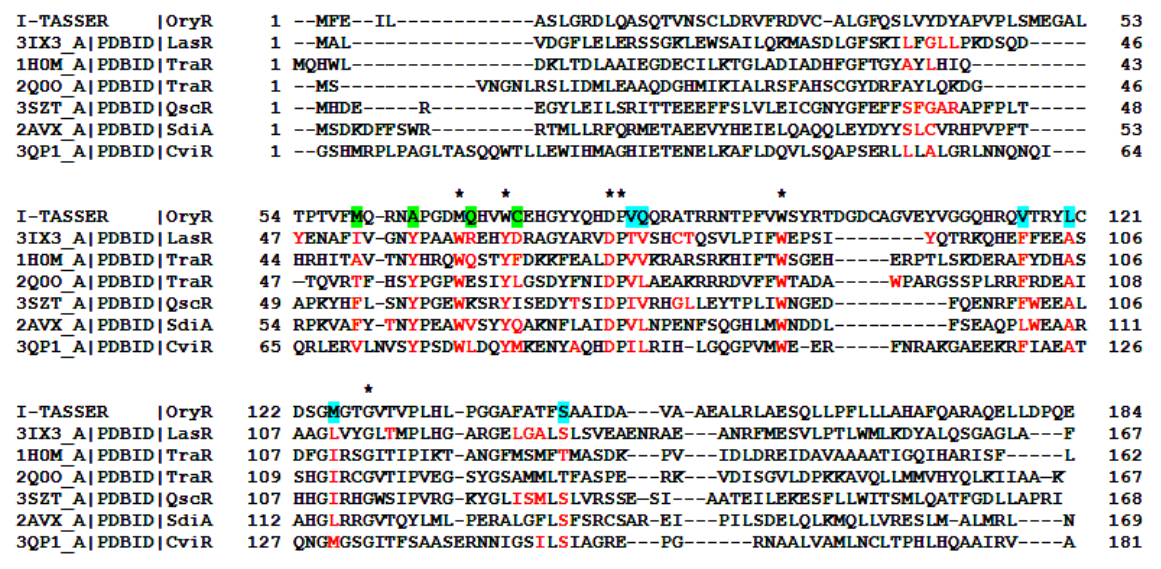
Figure 3. Structure-based multiple sequence alignment of the QS LuxRs with the prototype of the PAB LuxR solos subfamily. The residues of the QS LuxR involved in ligand binding are colored in red. The homologous residues of OryR, the prototype of PAB LuxR solos subfamily, belonging to Cluster 1 are highlighted by a star while the ones belonging to Cluster 2 and Cluster 3 (see text) are highlighted in cyan and in green